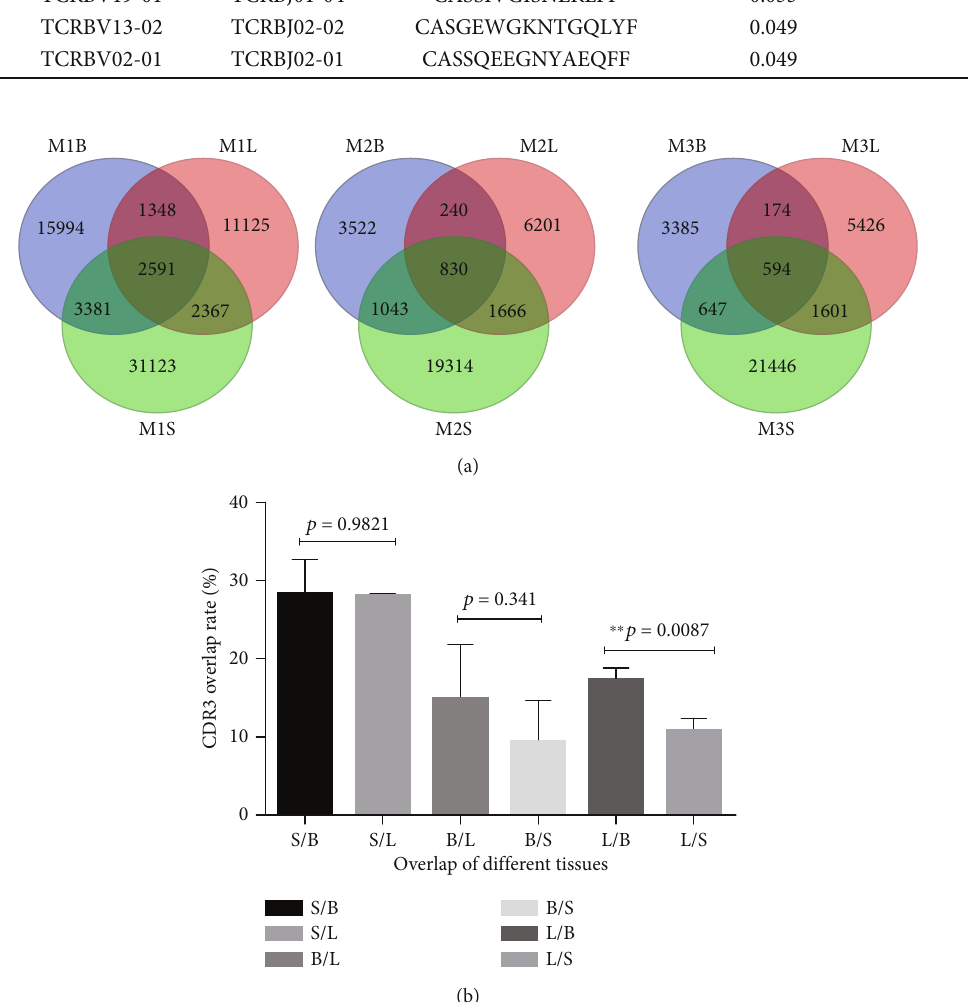
Figure 4: The number of public sequences of CD4 + CD25 + T cells TCR β CDR3 repertoires among three tissues of each 4T1 tumor-bearing BALB/c mice (a); the number and ratio (Supplement Table 4-1) and the statistical analysis (b) of public CDR3 sequences from their respective unique productive CDR3 repertoires in each type of tissue ( n = 3 , ∗∗ p < 0 : 01